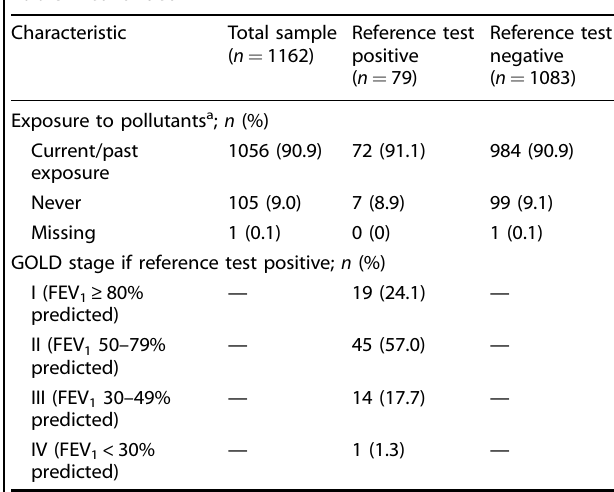
Table 1. Characteristics of study